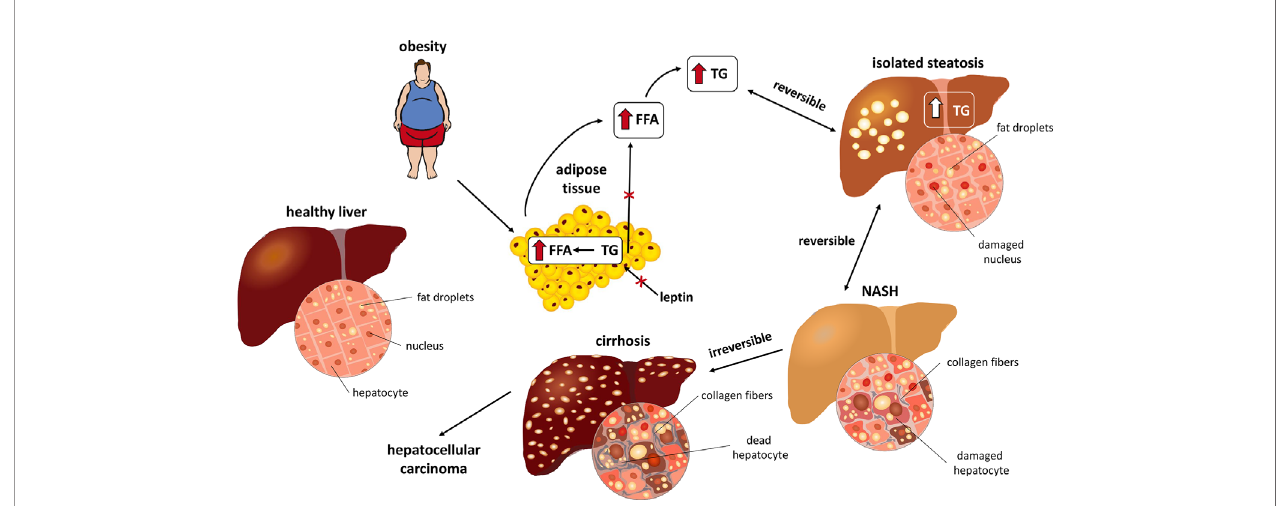
FIGURE 1 | Stages of